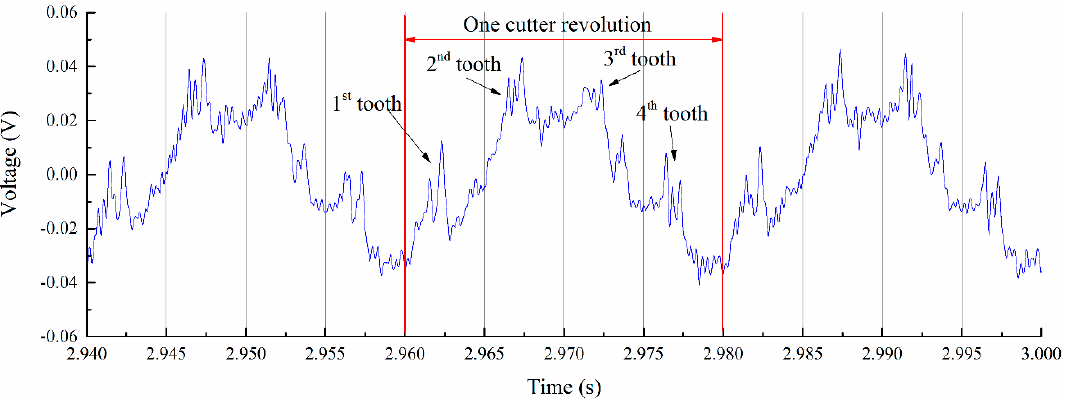
Figure 9. Workpiece deflection in the normal cutting stage.